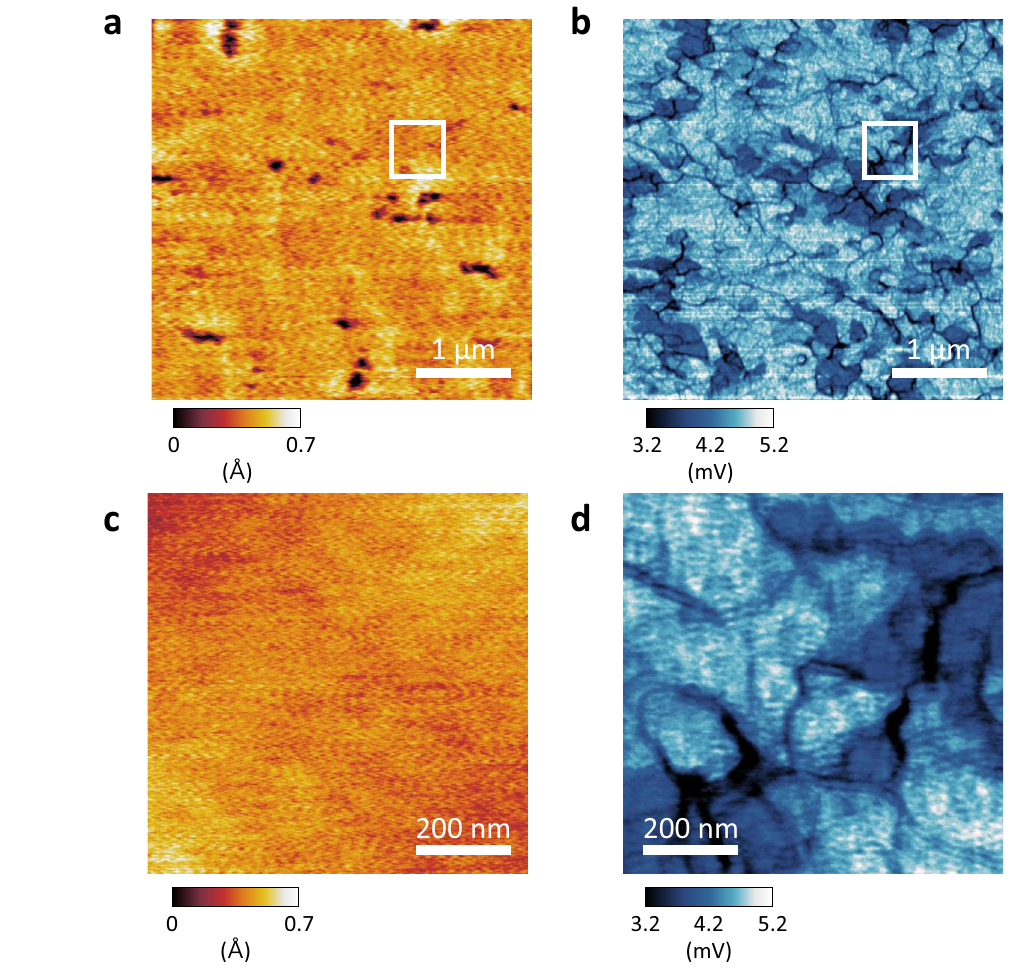
Fig. 4 | Large-scale imaging of phonon puddles in the commensurate CDW phaseof1T-TaS 2 bySThEM.a , b Topography a andthermopower b imagesovera distance of 4 μ m at T sample =78K. Defect areas (pits and grain boundaries) in a exhibit lower thermopower in b . The thermopower image shows complex pat- ternsthatarenotobservedinthetopography. c , d Magni fi edtopography c andthe